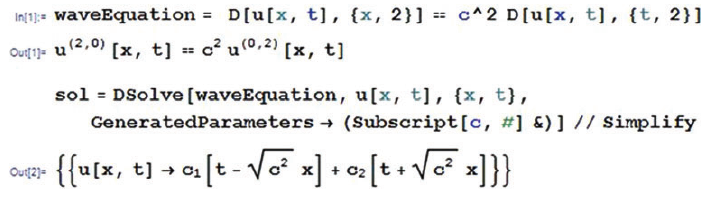
Figure 7 Mathematica ® primitives for solving the wave